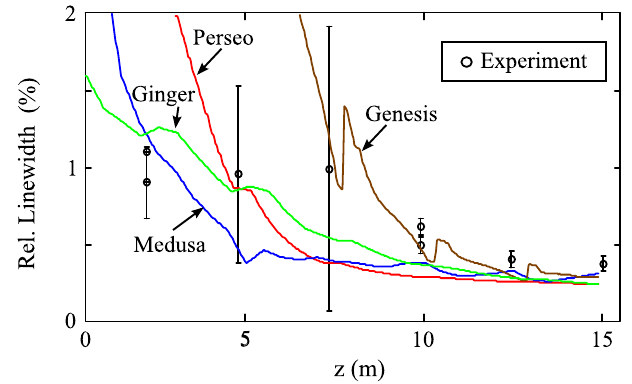
FIG. 14. Experimental linewidth of the FEL radiation (black circles) as a function of the longitudinal position in the undu- lator. The lines represent simulation data obtained with PERSEO (red), GENESIS 1.3 (brown), MEDUSA (blue), GINGER (green). The error bars represent (cid:2) 2 standard deviation of the measured linewidth evaluated over 50 samples.